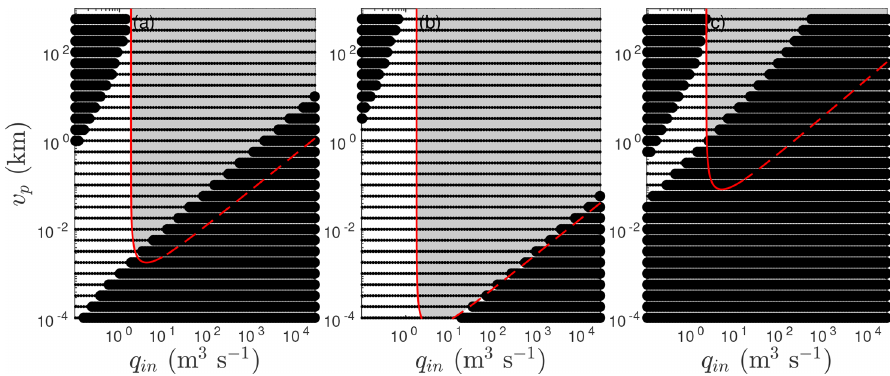
Figure 13. Stability of steady-state solutions to the model (6) with parameters given by Table 1 and L = 50km (a) , 250km (b) and 10km (c) . Solid black circles indicate parameter combinations for which the steady-state solution to the full model (1) is stable, and small dots indicate that the full model is unstable. The red curves indicate the stability boundaries of the lumped model (2) with V p = v p L